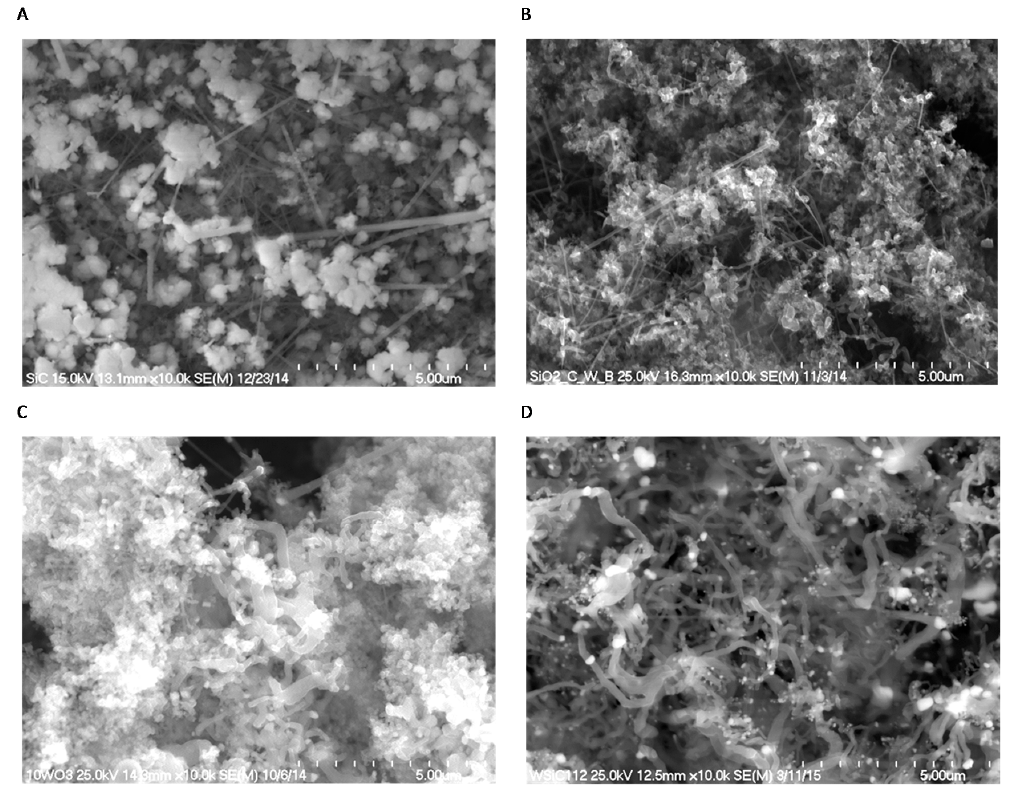
Figure 2. Low magnification SEM micrographs of the nanocomposites: ( A ) β -SiC; ( B ) (5) W x C- β -SiC; ( C ) (10) W x C- β -SiC and ( D ) (20) W x C- β -SiC. (The numbers in round brackets (5), (10) and (20) show the amounts of W in the catalysts).